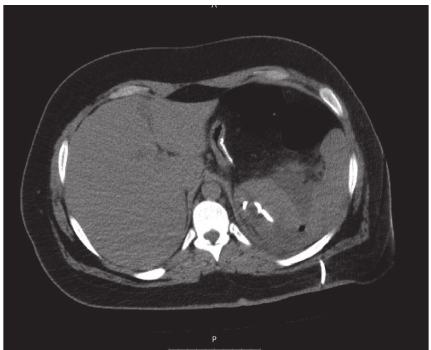
Figure 2: Percutaneous drainage of the splenic abscess.